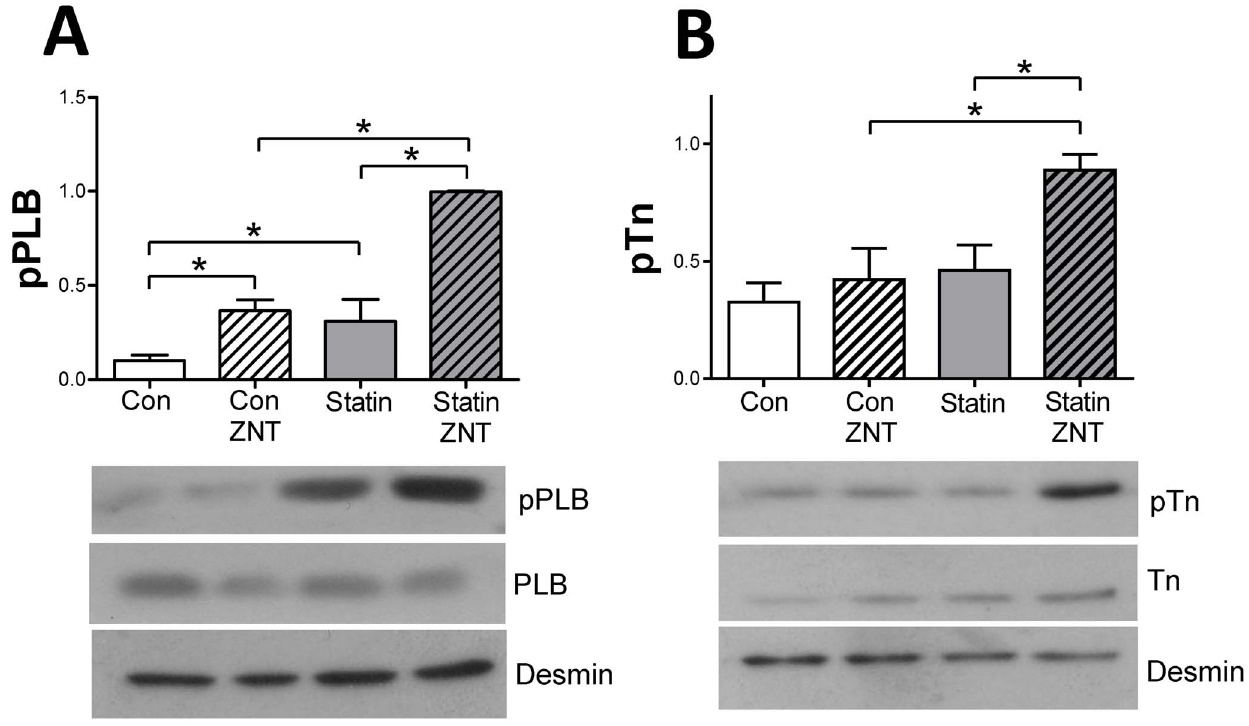
Figure 7. Simvastatin treatment modulates phosphorylation of PLB and TnI following b 2-AR stimulation. A. Representative immunoblots and mean data showing levels of Ser 16 phosphorylated phospholamban (pPLB) under basal conditions and following b 2-AR stimulation with 100 nM zinterol (ZNT) + 10 nM CGP20712A. B. Representative immunoblots and mean data showing levels of Ser 23/24 phosphorylated troponin I (pTnI) under basal conditions and following b 2-AR stimulation. Simvastatin had no significant effect (P . 0.05) on expression of PLB or TnI. All phosphorylated protein data are normalised to desmin expression. n=4 hearts. * P , 0.05, 2-way ANOVA.